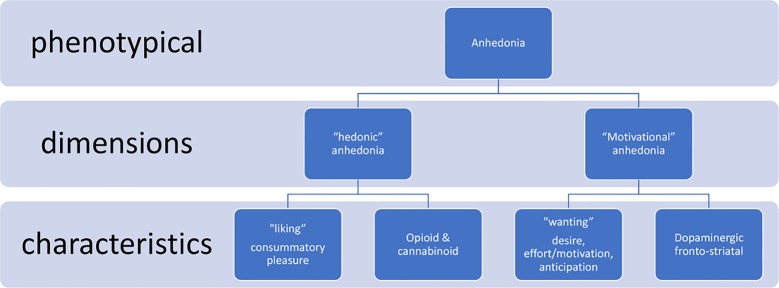
Anhedonia dimensions (11, 18).